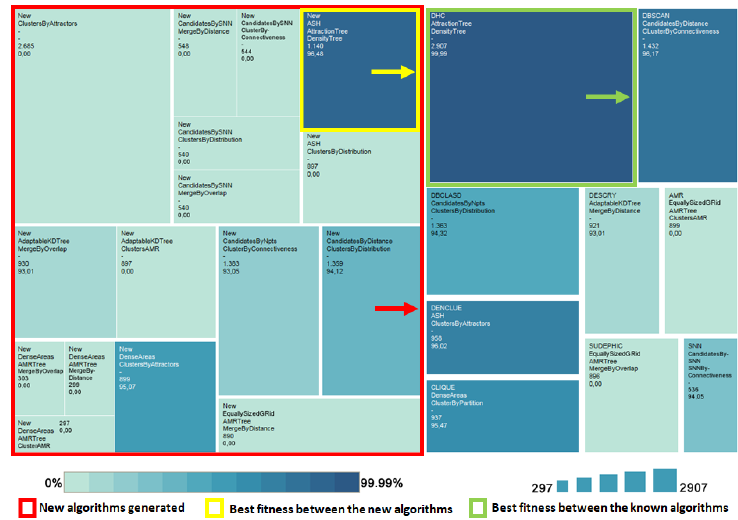
Figure 4. Overview of algorithms using the Treemap visualization technique considering the highest fitness value and the mean occurrence rates of the clustering algorithms after all